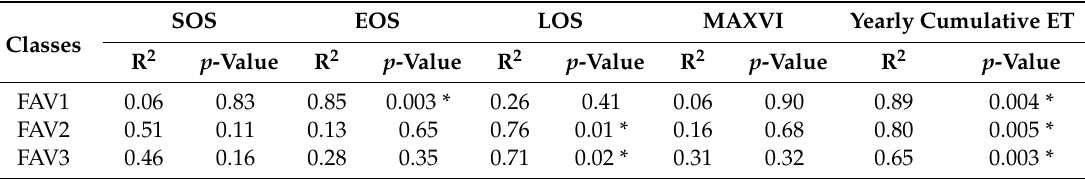
Table 6. Coe ffi cient of determination (R 2 ) and p -value resulting after modeling relationships between PMs / ET and IKC Pr at altitude class level. A 2nd order polynomial was used for modeling. (*) indicates statistically significant cases (* p < 0.05).